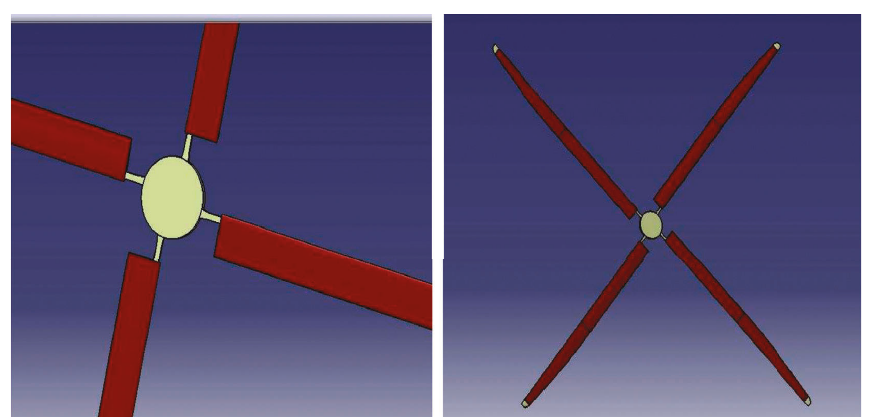
Figure 2: HH02 rotor